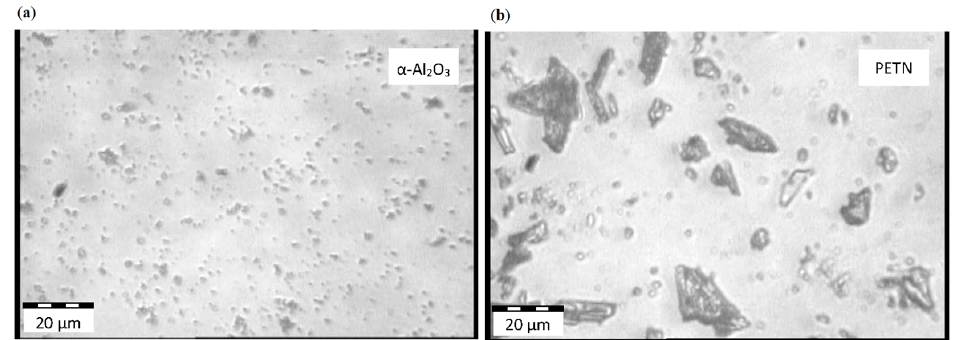
Fig ure 5. Microphotographs of ( a ) α -Al 2 O 3 and ( b ) PETN samples. Figure 4. Microphotographs of ( a ) α -Al 2 O 3 and ( b ) PETN